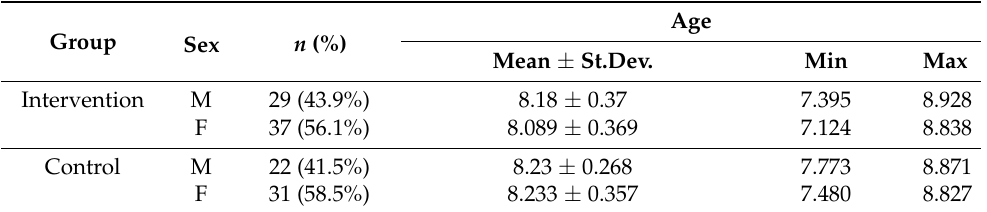
Table 1. Demographic characteristics of participants by intervention